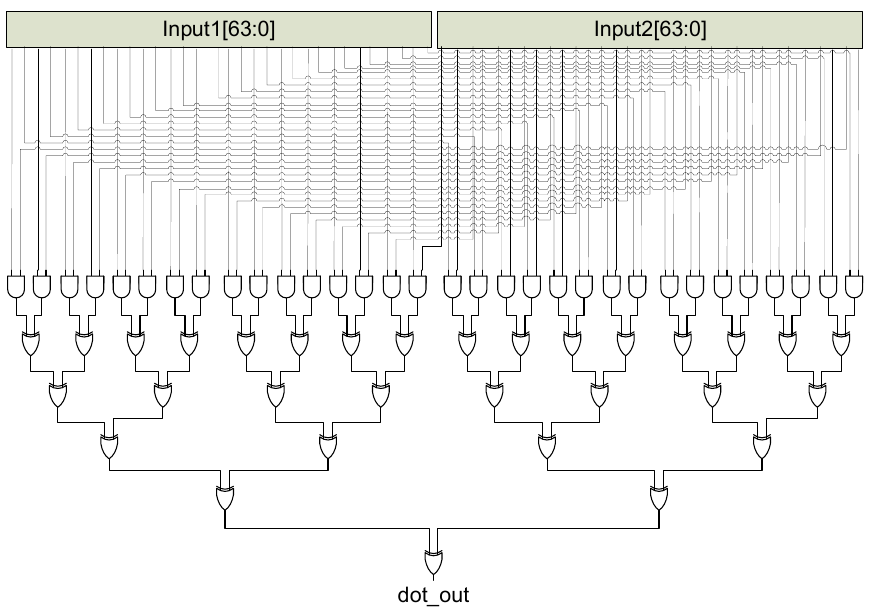
Figure 7. Proposed high latency dot product unit.